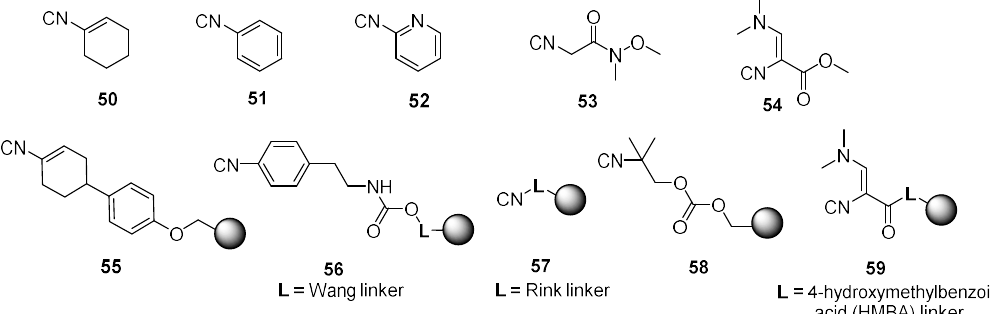
Figure 2. Solution-phase and resin-bound convertible isocyanides.